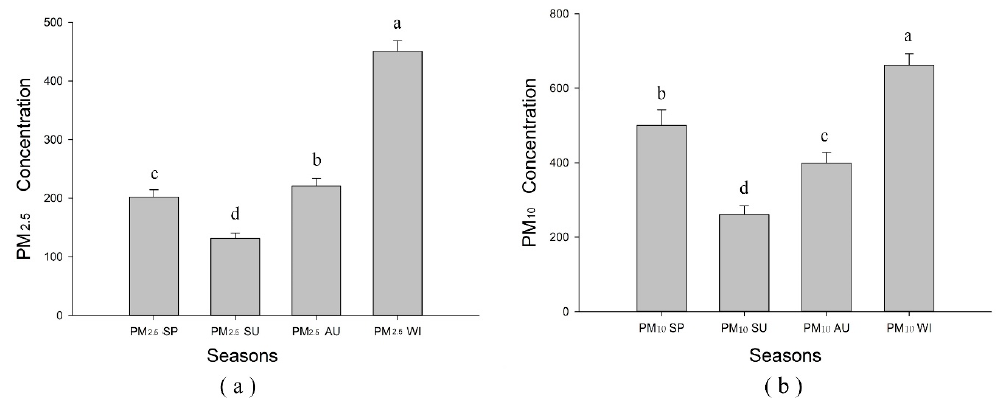
Figure 3. Analysis of variance (ANONA) analysis of PM 2.5 and PM 10 concentrations in four seasons. ( a ) seasonal ANOVA of PM 2.5 concentration; ( b ) seasonal ANOVA of PM 10 concentration.